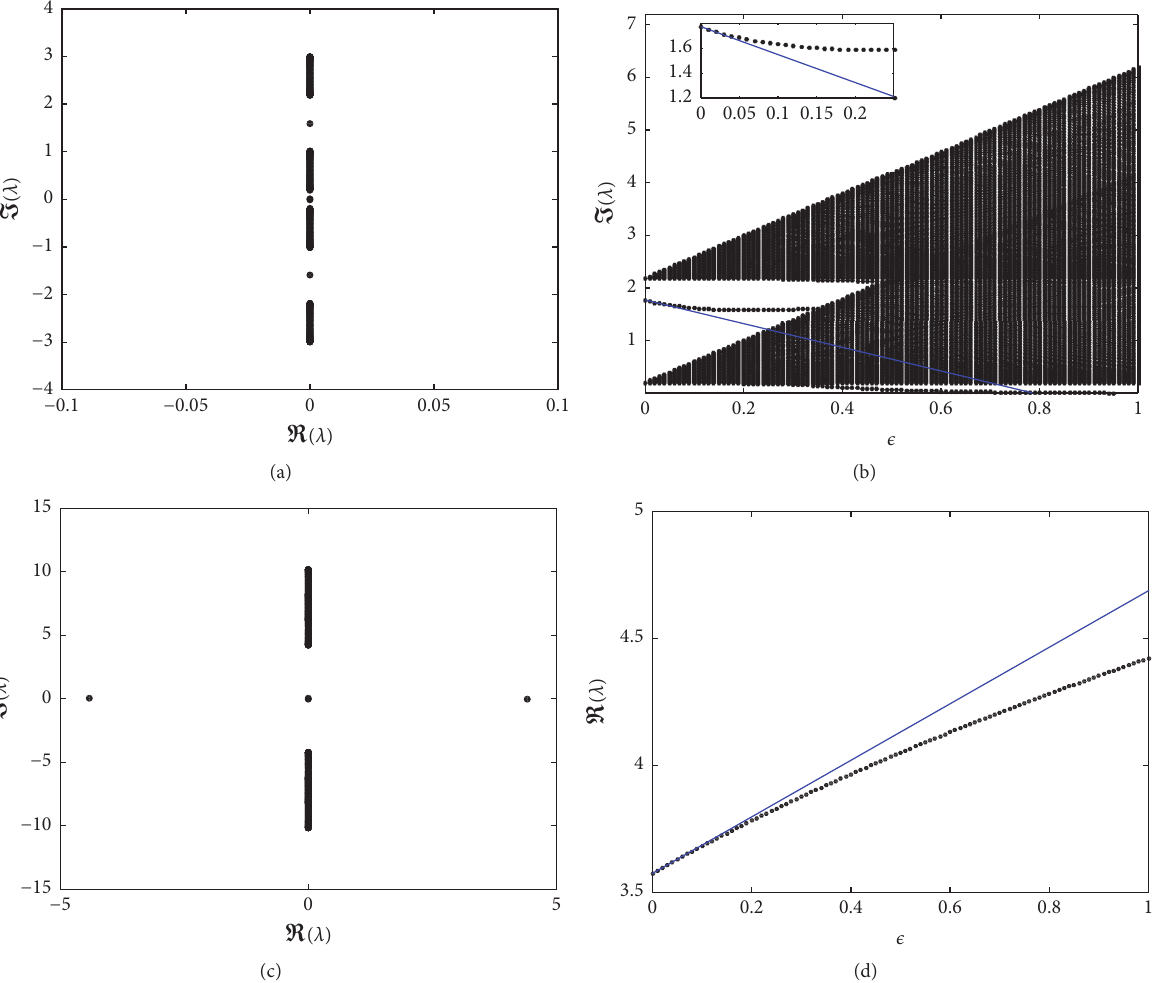
Figure 4: (a, c) The spectrum of onsite soliton I in the complex plane for 𝜖 = 0.2 . (b, d) The eigenvalue as a function of the coupling and its approximation from Section 4.2.3. (a–d) are for 𝜔 = 1.2 and 5.2 , respectively. Here, 𝛾 = 0.1